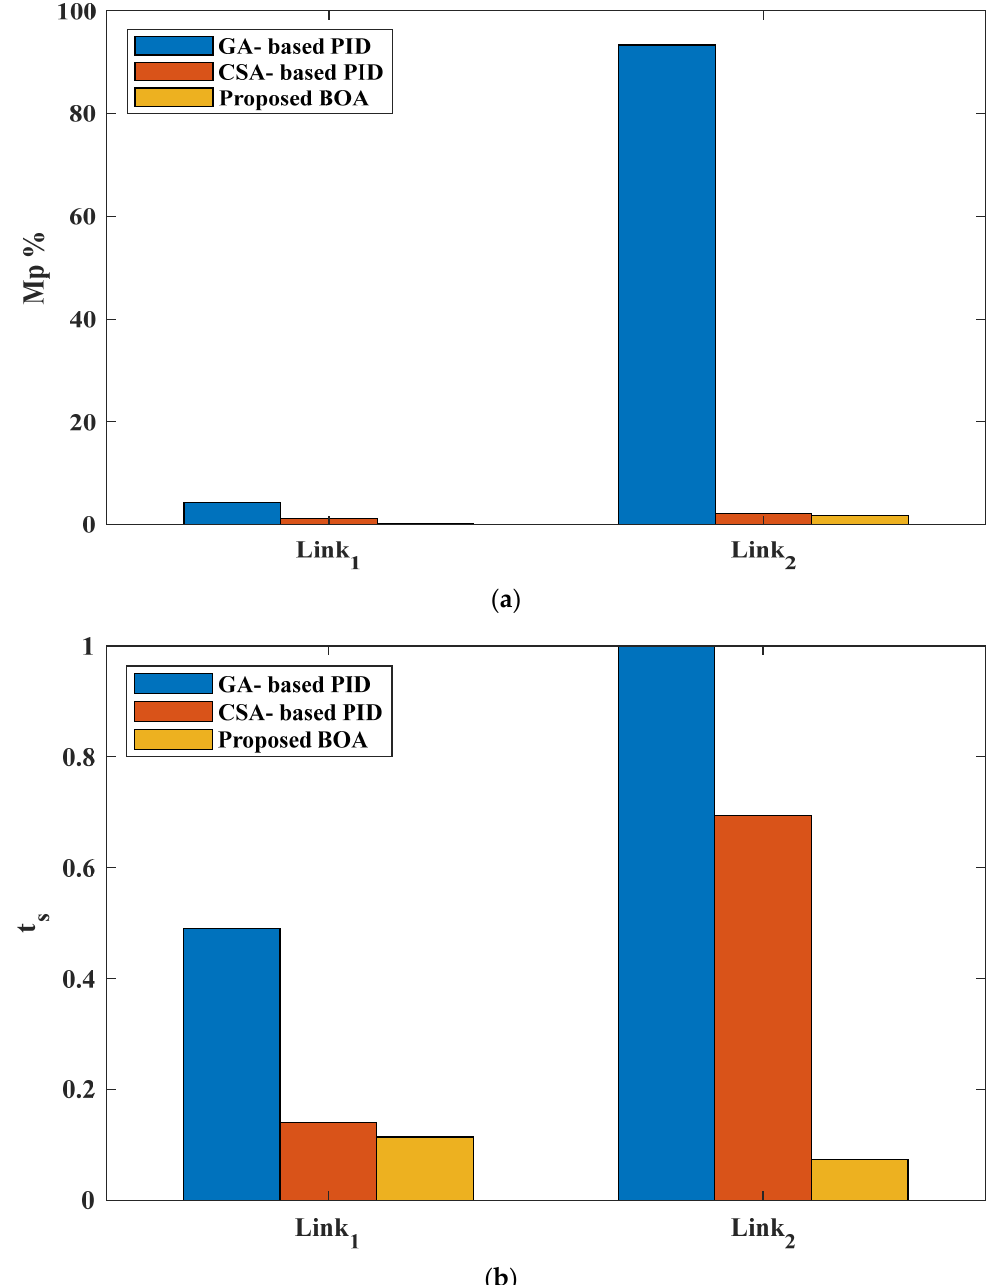
Figure 7. The dynamic characteristics of each technique ( a ) system extreme overshoot ( b ) system-settling time.